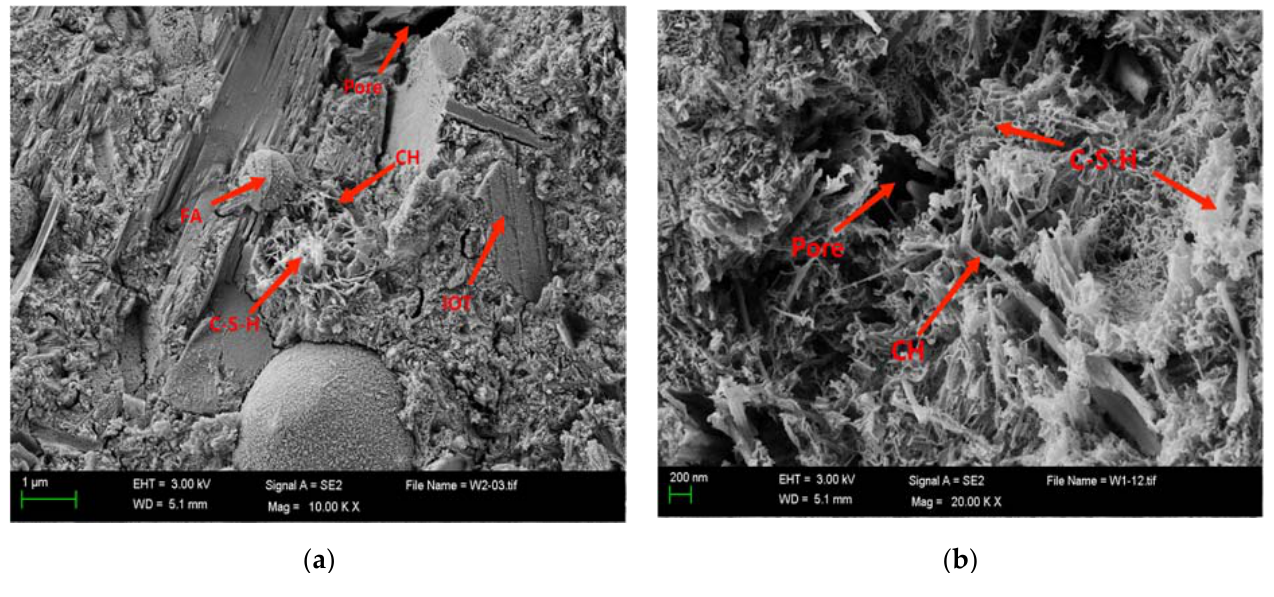
Figure 7. SEM analysis results of the ICF-10 specimen for 28 days. ( a ) Not fully hydrated; and ( b ) more fully hydrated.